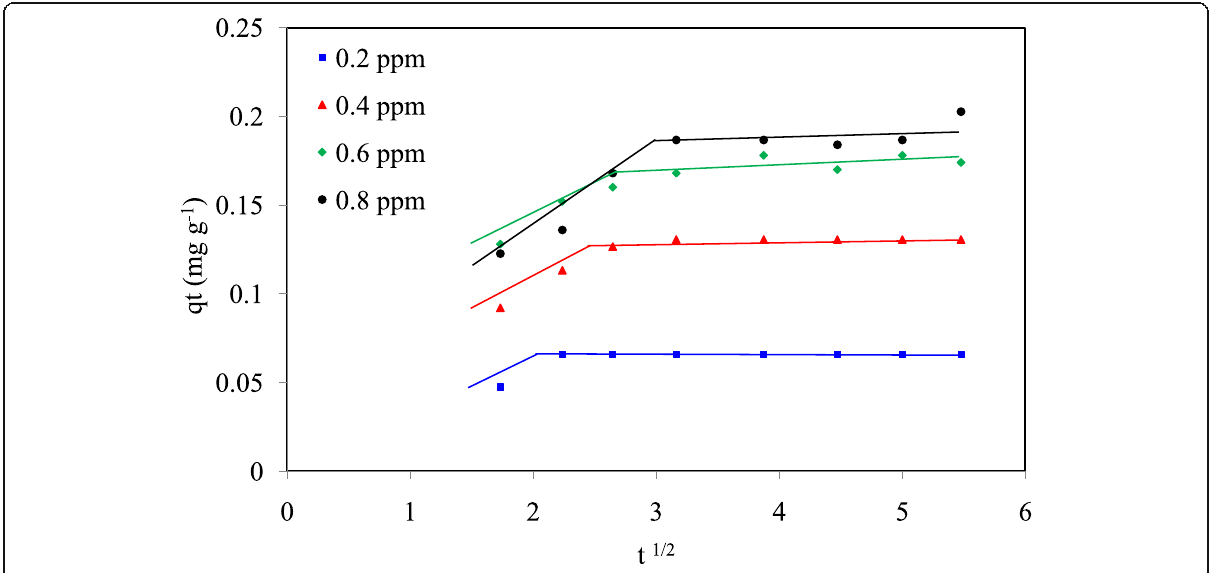
Fig. 7 Plot of the intra-particle diffusion equation for the adsorption of arsenic